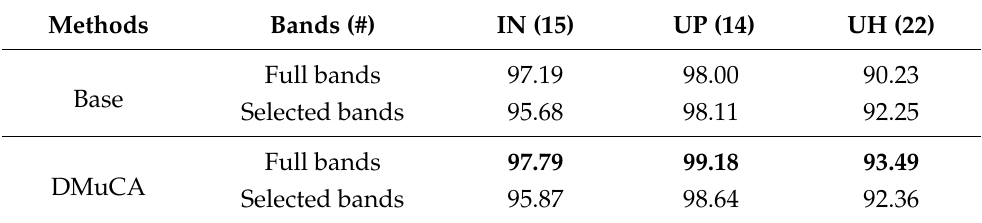
Table 6. Classification performance of DMuCA with full or selected bands as the input (OA%). The best results are highlighted in bold font.